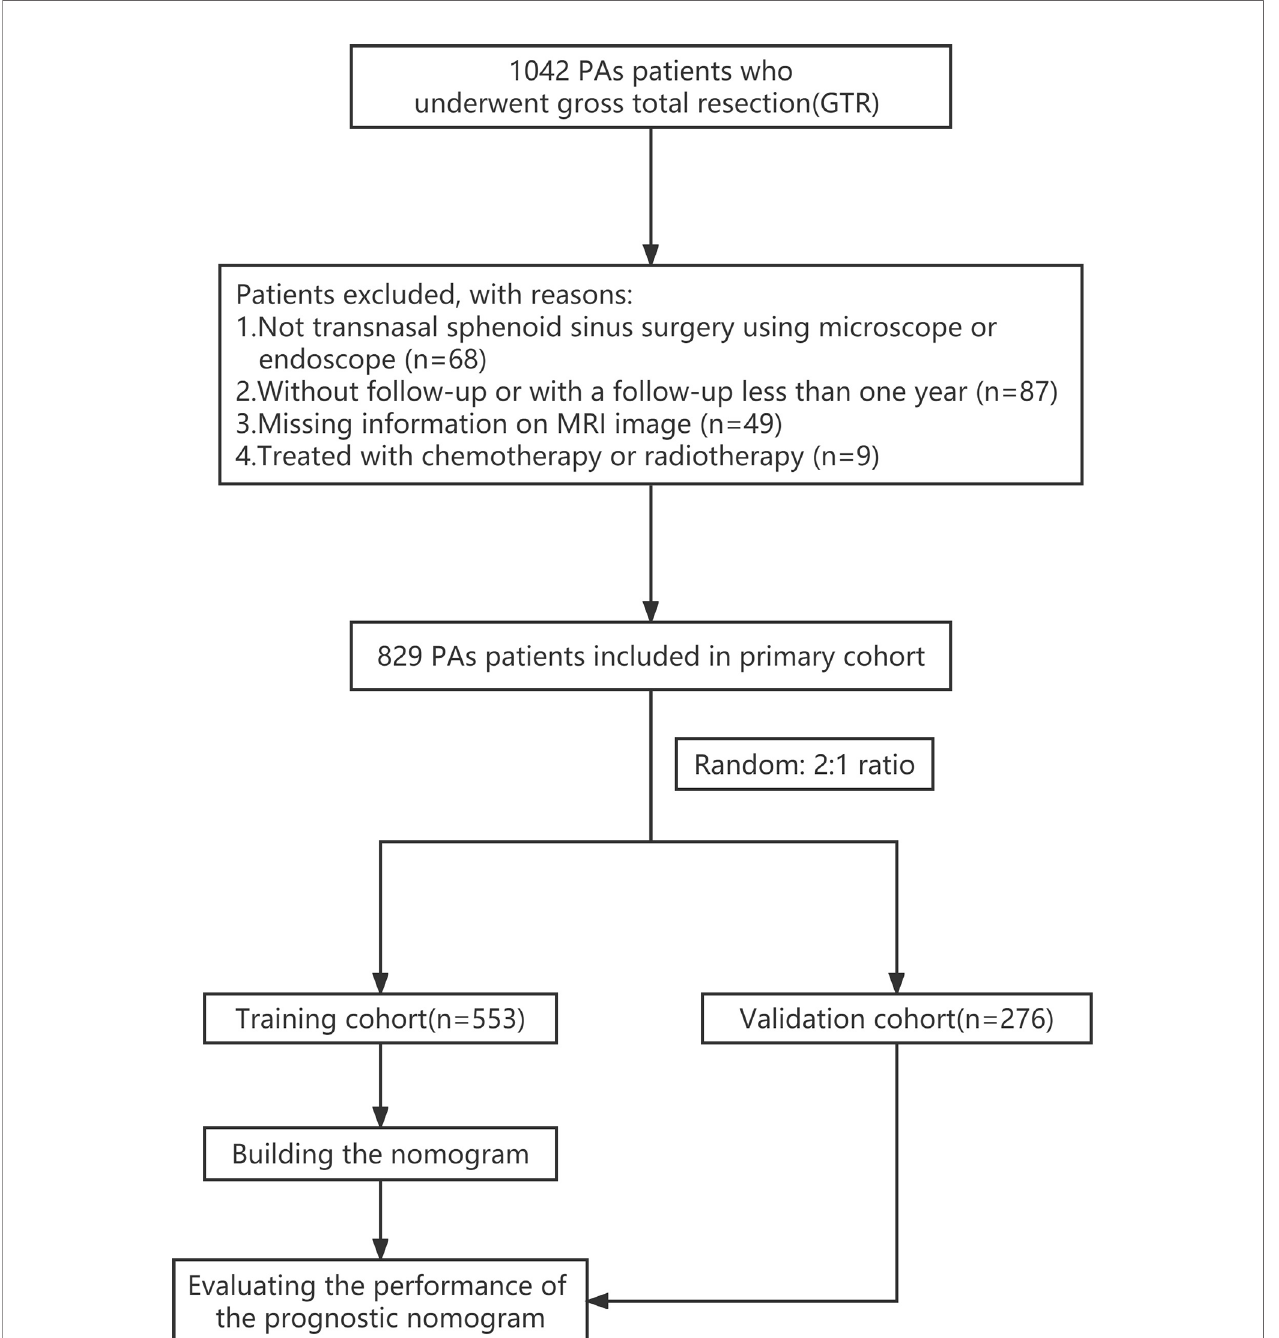
FIGURE 1 | Flowchart summarizing the enrollment strategy and design of the study. PAs, pituitary